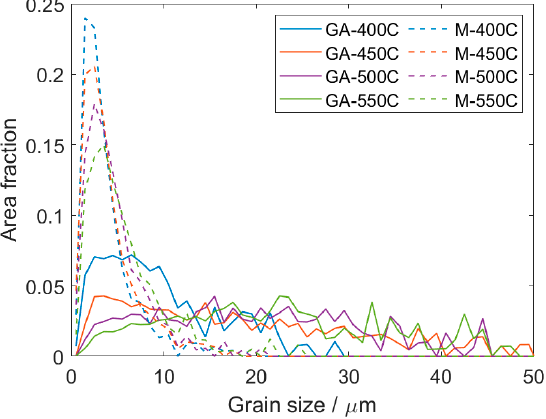
Figure 4. Grain size distribution calculated from EBSD data for all investigated samples.